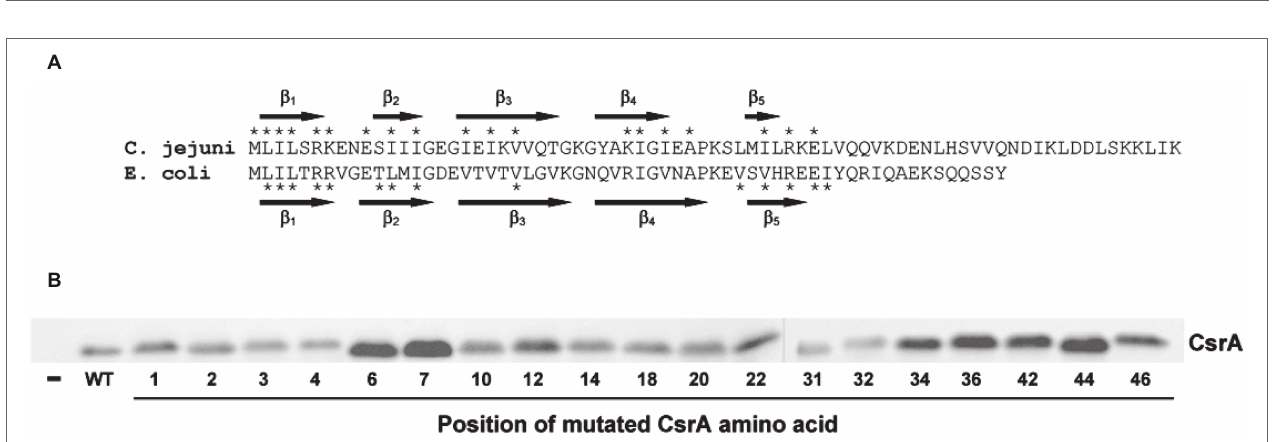
FIGURE 6 | Quantification of regulatory activity by WT and mutant CsrA proteins. E. coli BL21(DE3) was co-transformed with the translational reporter pJOFE and either: pET-20b (negative control, labeled “−”), pET-20b-CsrA (positive control, labeled “WT”), or each of the 75 pET-20b-CsrA point mutants. AstA activity in these cells was quantified by arylsulfatase assay (Y axis). The positions of CsrA mutations are indicated below the X axis. Experiments were done a minimum of three times, using triplicate samples. Results were analyzed using one-way ANOVA with Dunnett’s multiple comparisons test, using p < 0.05 to indicate significance.